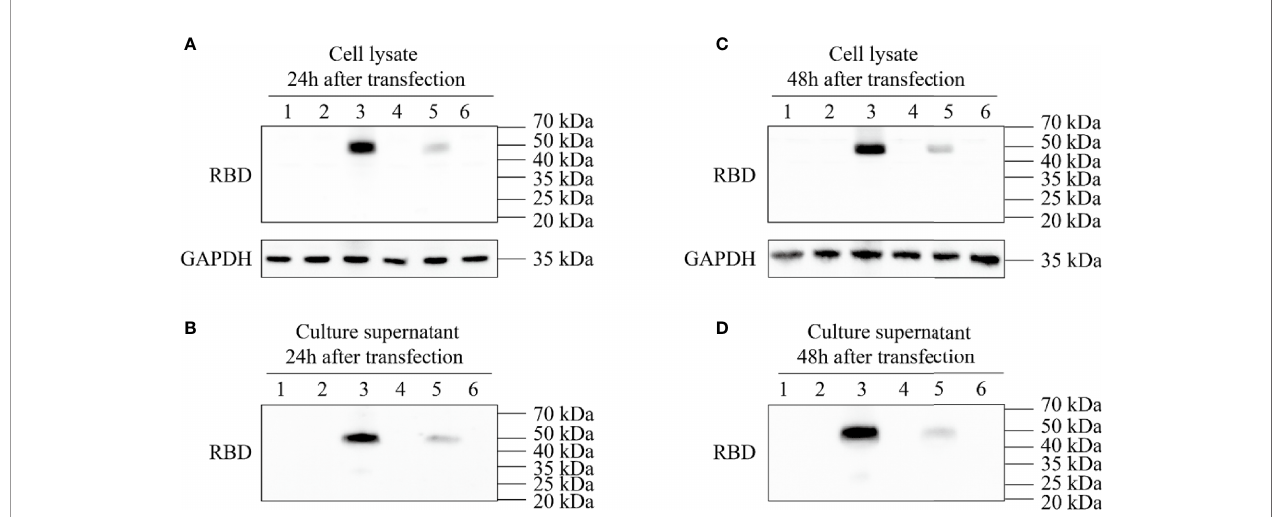
FIGURE 2 | Expression identi fi cation of recombinant plasmid pAAV-RBD. HEK293 cells were transfected with the four different plasmids and the RBD expressions were detected in the cell lysates or supernatants. 1: Negative control; 2: Clone 1; 3: Clone 2; 4: Clone 3; 5: Clone 4; 6: EGFP plasmid. (A) Expression of RBD in the cell lysate 24 hours post-transfection. (B) Expression of RBD in the culture supernatant 24 hours post-transfection. (C) Expression of RBD in the cell lysate 48 hours post-transfection. (D) Expression of RBD in the culture supernatant 48 hours